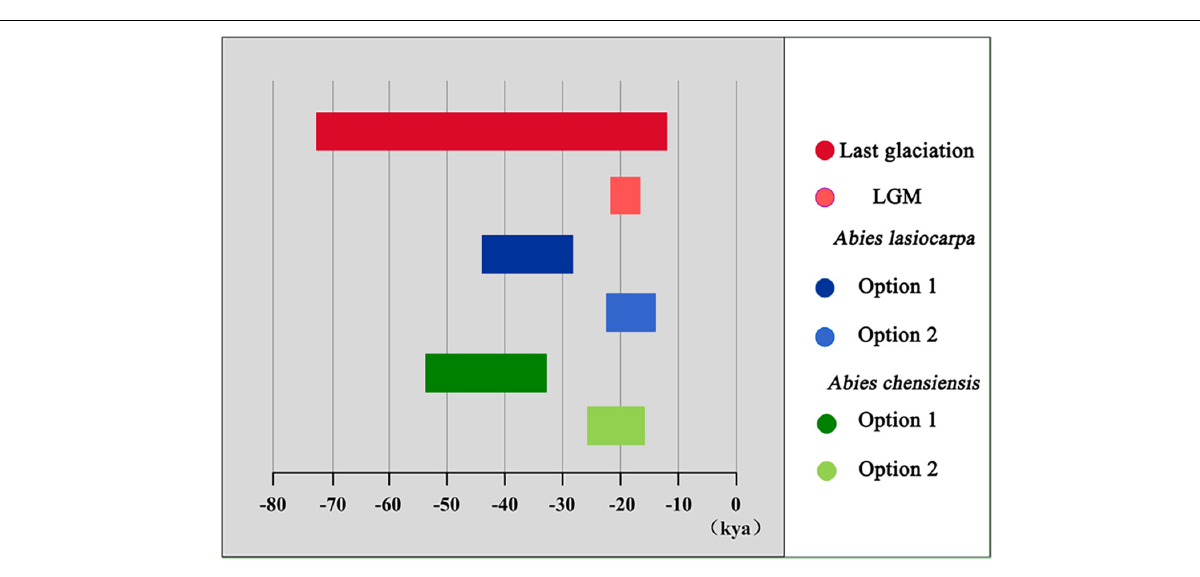
Frontiers in Ecology and Evolution |